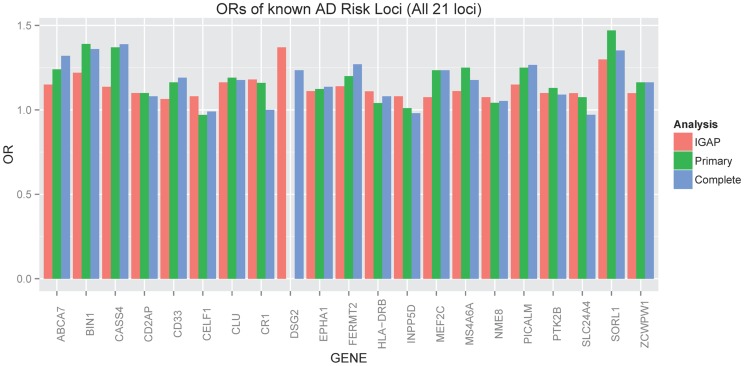
Barplot of OR for known AD risk loci (all 21 loci).Red indicates the estimated OR previously reported through the IGAP consortium [11], green indicates the estimated OR from our primary clinico-neuropathologic case-control analysis, and blue indicates the estimated OR from a more restrictive analysis that required complete documentation of all relevant neuropathologic phenotypes.